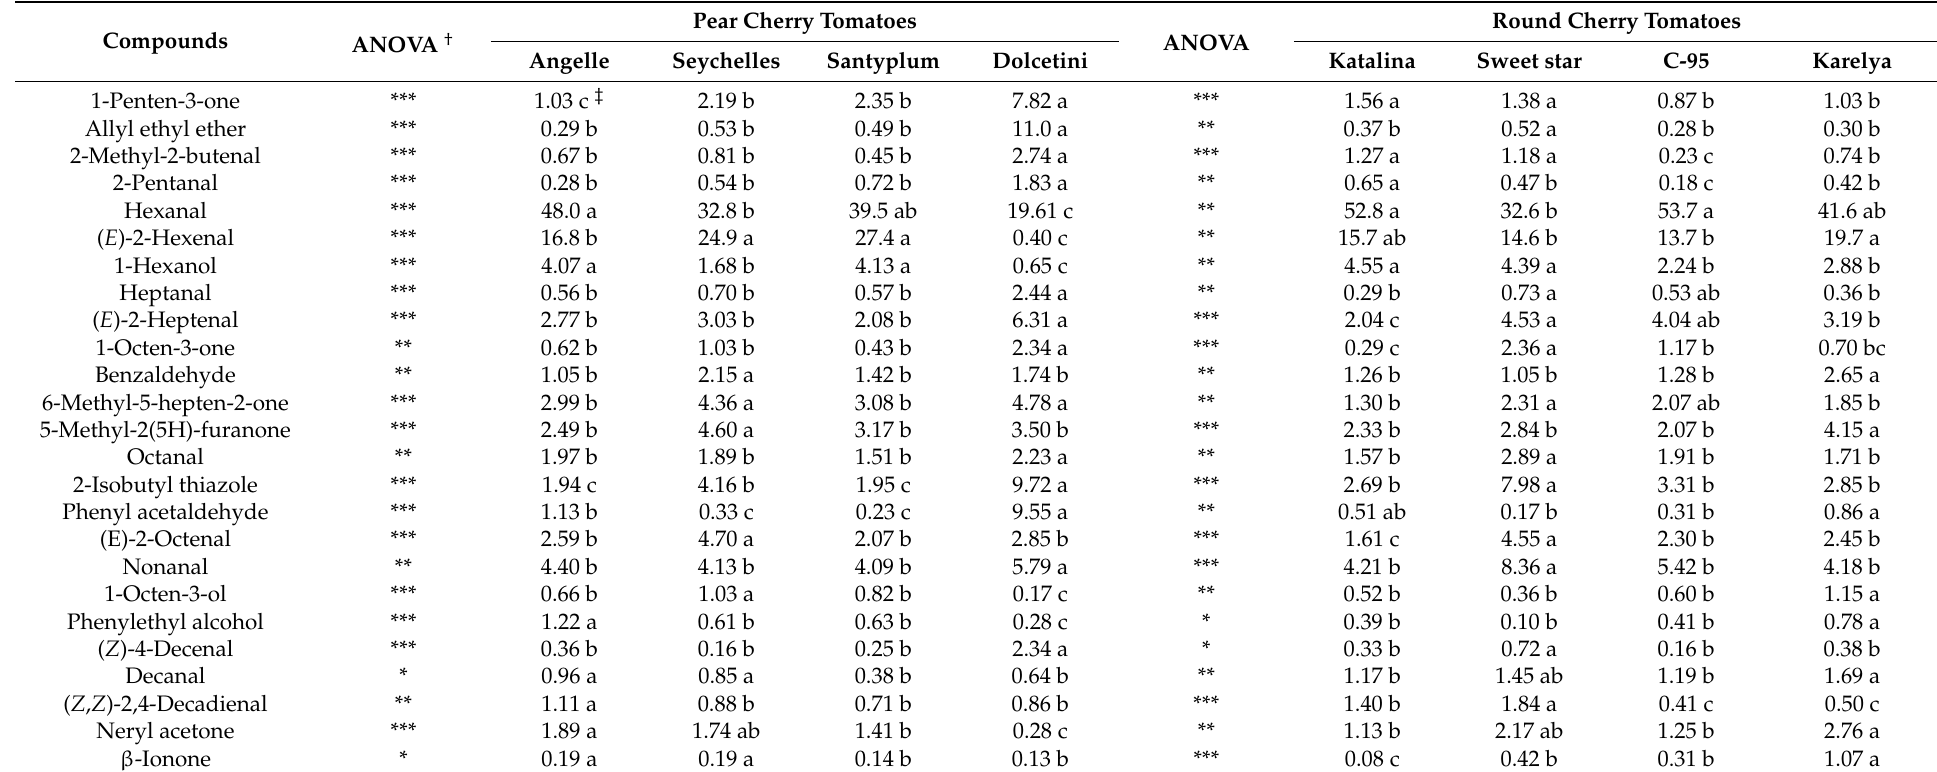
Table 3. Relative abundance (%) of volatile compounds in cherry tomatoes as affected by cultivar for pear and round fruits. Pear Cherry Tomatoes Round Cherry Tomatoes Compounds ANOVA † ANOVA Angelle Seychelles Santyplum Dolcetini Katalina Sweet star C-95